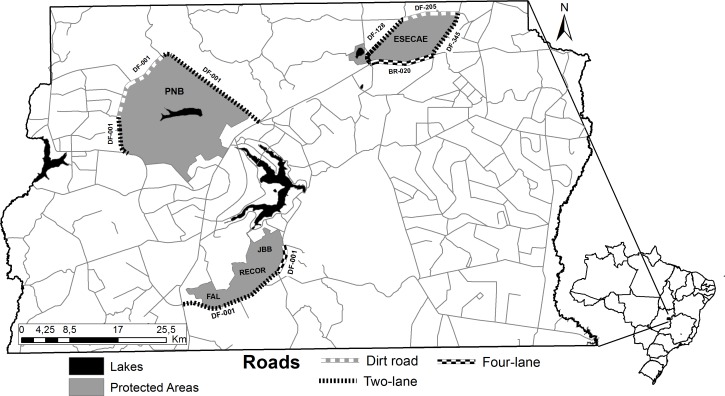
Study area with location of monitored roads and protected areas.Reprinted from Brasilia Environmental Institute (IBRAM) under a CC BY license, with permission from the head of the management of environmental information of IBRAM, original copyright 2016.